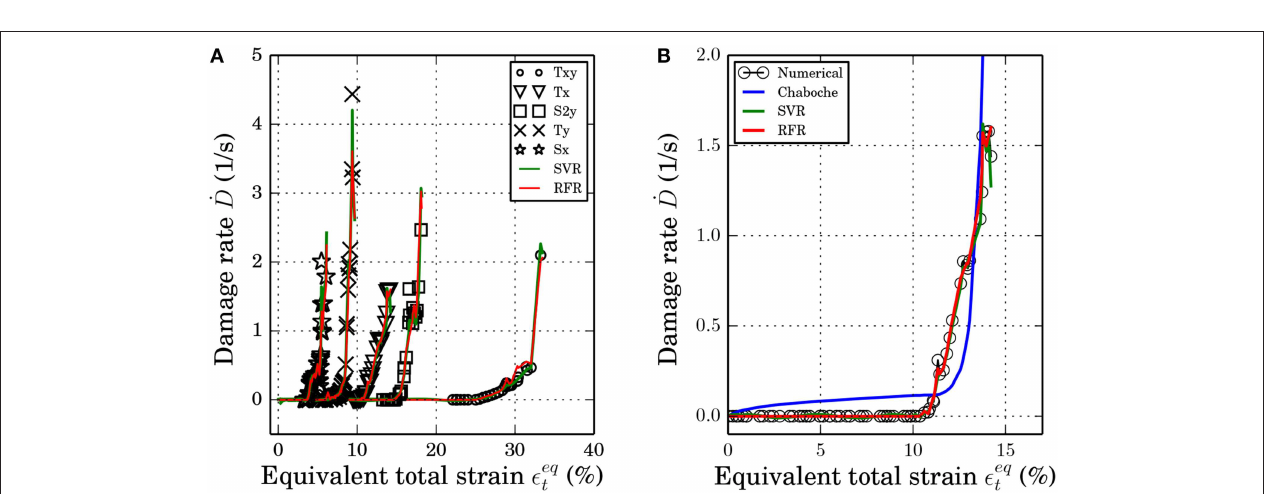
FIGURE 7 | ML results of the test set (25 % of the data) with predicted values plotted against target values, a points with a lower or equal R 2 score of 95 % (cyan color) (A) SVR with a score of R 2